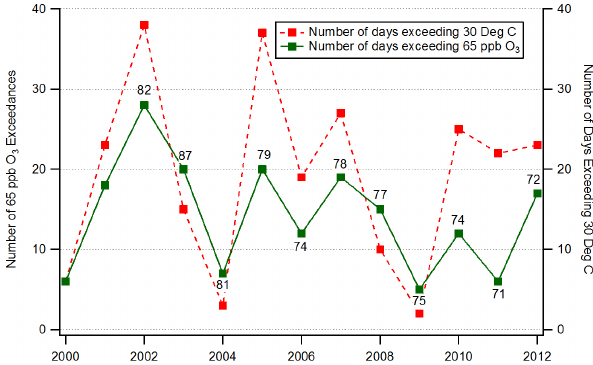
Figure 4. The number of days exceeding 65ppb O 3 Canada-wide Standard (green) and the number of days exceeding 30 ◦ C (red) at the Toronto Downtown2 station. The number above each marker is the design value for that